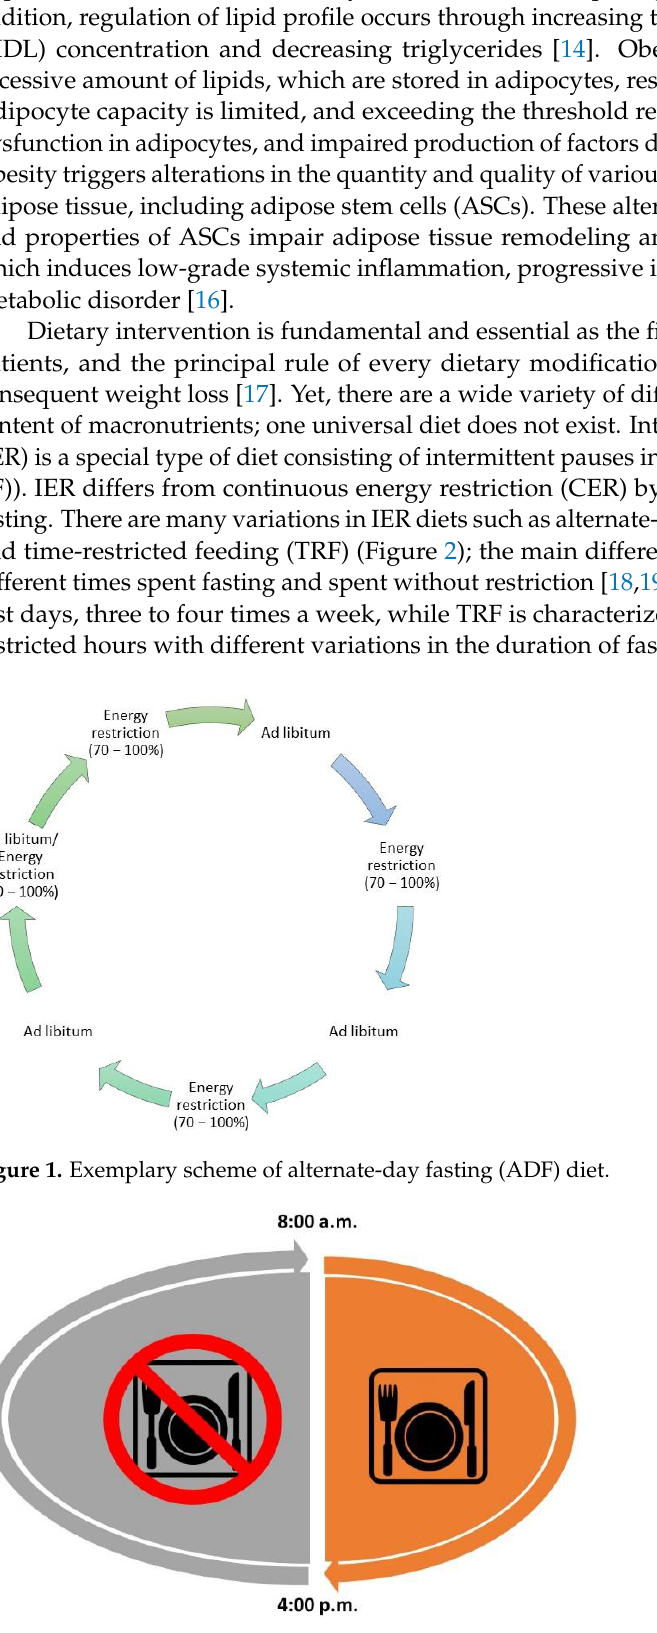
Figure 2. Graphical presentation of time-restricted feeding (TRF) diet.